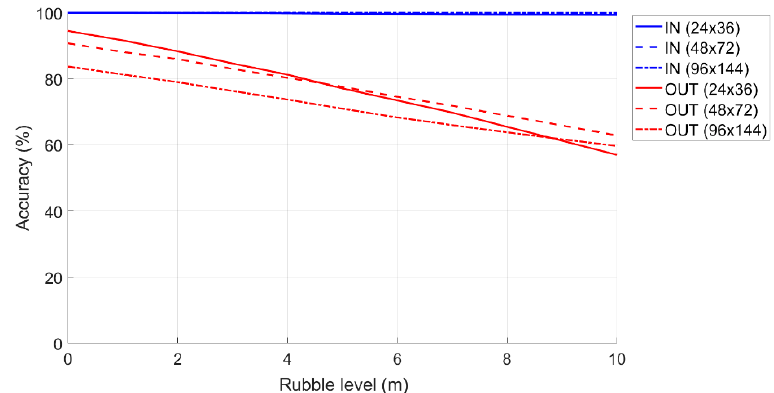
Figure 19. Accuracy in the classification of the IN and OUT terminals as the amount of rubble level increases with the “Safe Zone” by 10%.